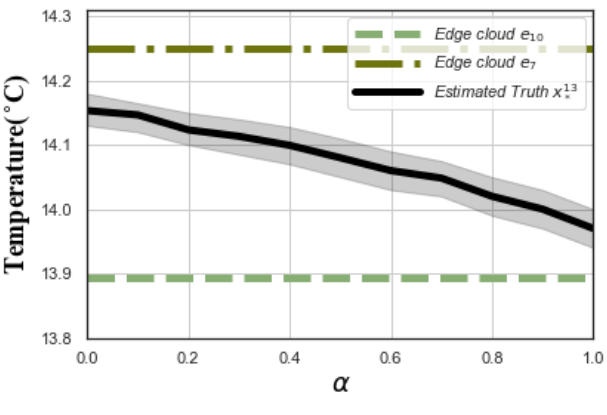
Figure 3. MAPE versus α ( G 7 = 300, G 10 = 100).